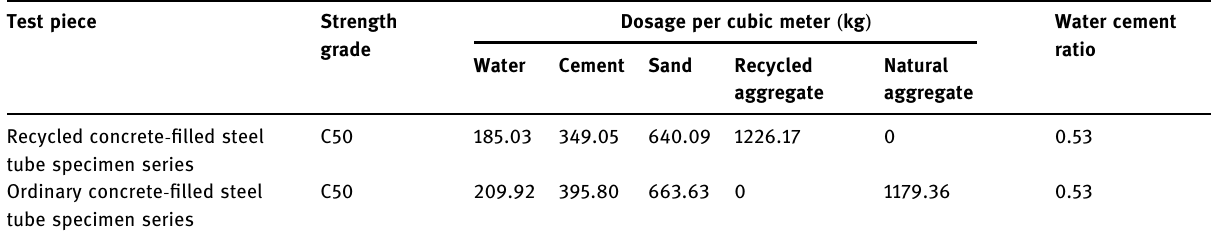
Table 5: The design of the core concrete ’ s mix proportion